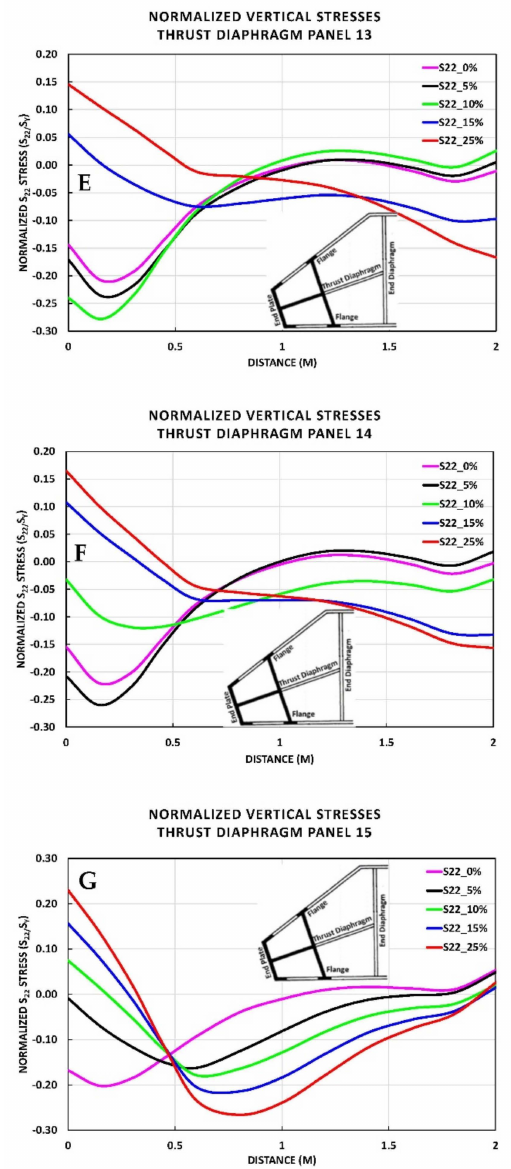
Figure 16. ( A – G ) Calculated vertical stresses along seven horizontal paths within the thrust diaphragm. Panels 13 and 14 (Figure 16E,F) demonstrate similar behavior to Panels 11 and 12 (Figure